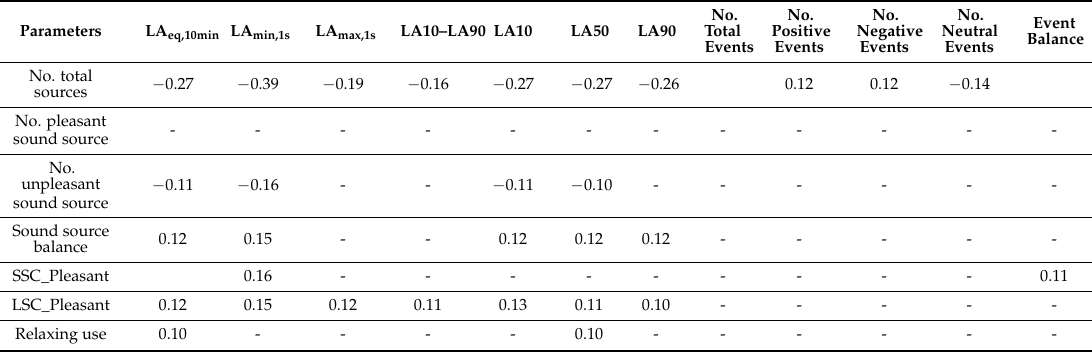
Table 6. Pearson significant correlation ( p < 0.05) between acoustic parameters and pleasantness of sources, landscape and